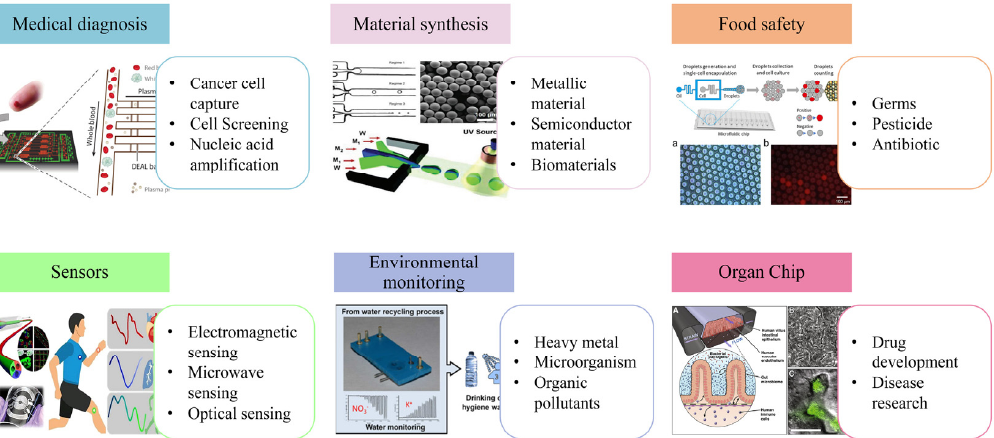
Figure 1. Microfluidic chips are widely used in medical diagnosis, material synthesis (adapted with permission from [10] . Copyright {2005} American Chemical Society) (adapted with permission from [11] . Copyright {2006} American Chemical Society), food safety, sensors, environmental monitoring, and organ chips, among others.